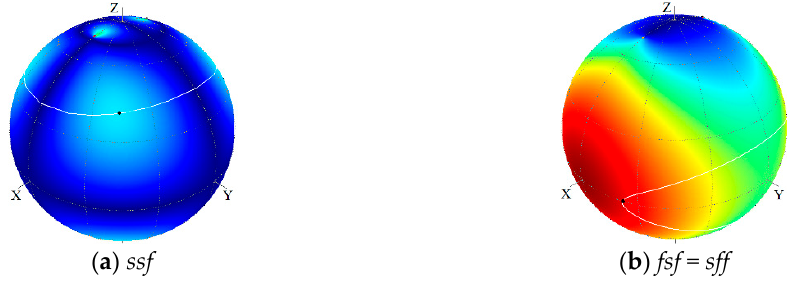
Figure 1. Distribution of d eff ( φ , θ ) and phase-matching directions for SHG in KTP crystal: ( a ) ssf -, and ( b ) sff = fsf types of interactions